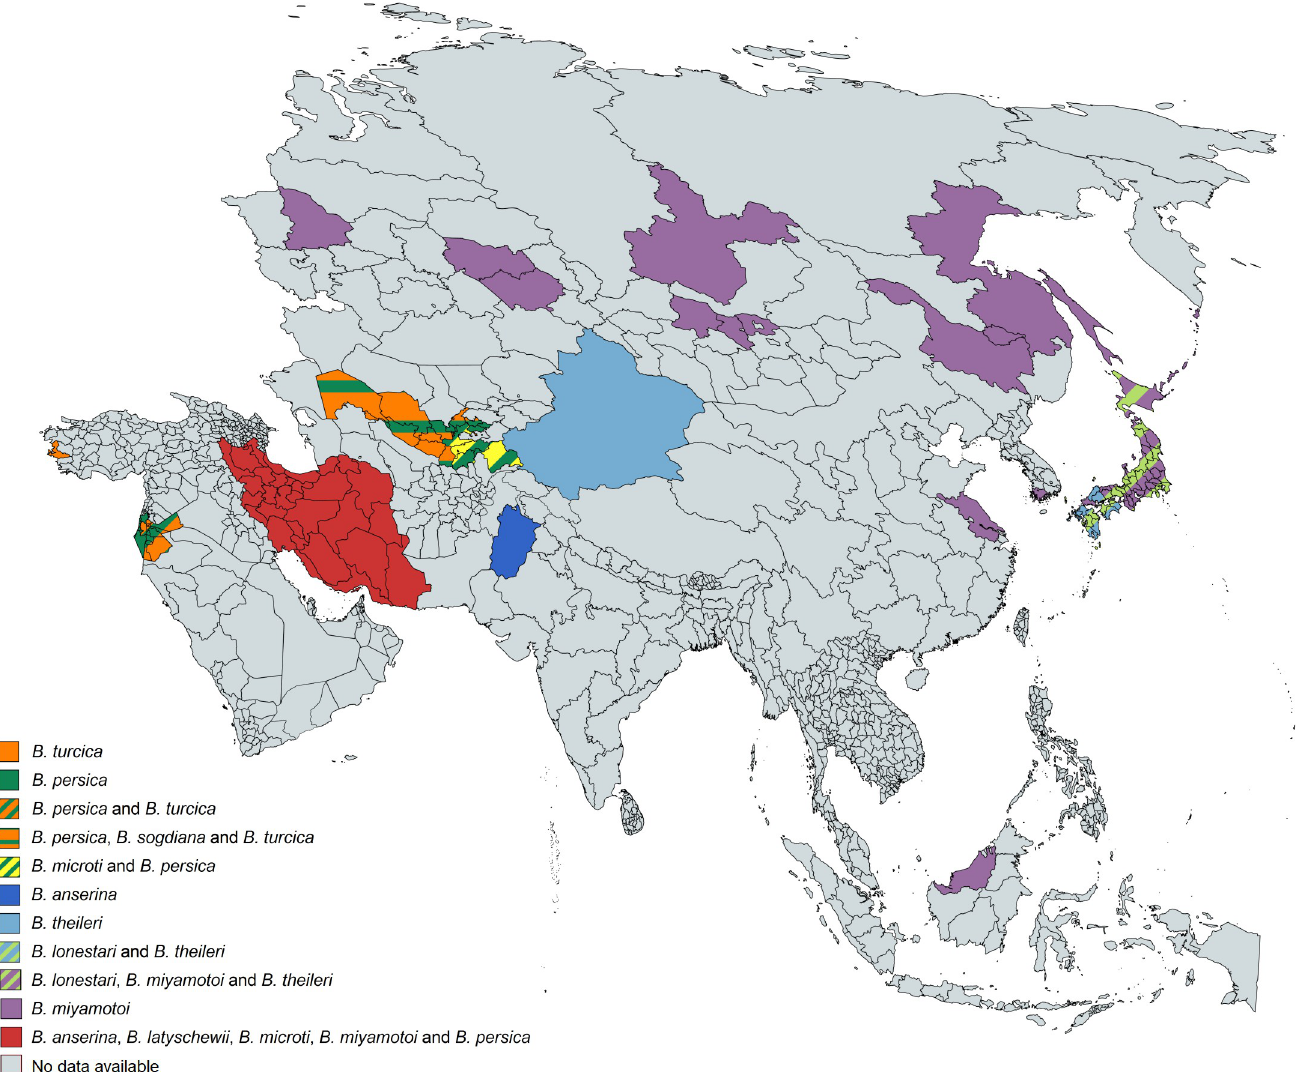
Fig 10. Reported presence of TBRF Borrelia species in ticks and animal hosts in Asia. B., Borrelia . Map created on